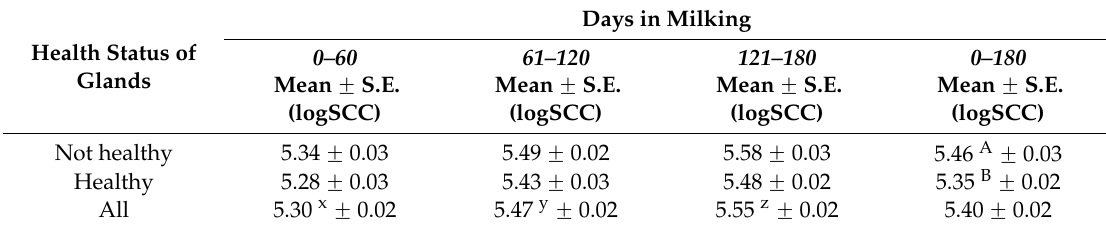
Table 7. Overall means and standard errors (S.E.) of SCC (log) of gland milk samples according to mammary gland health status and lactation stages.